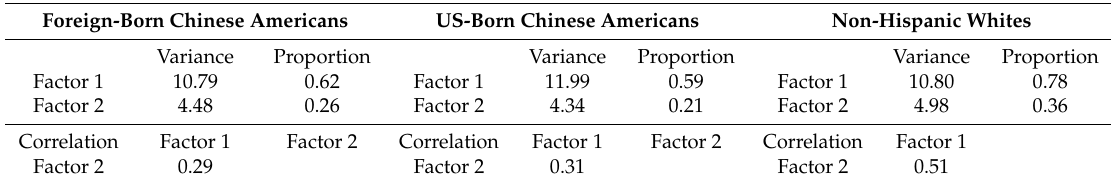
Table 3. Factor Analysis